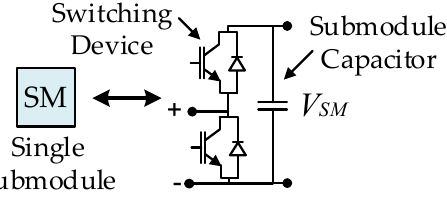
Figure 3. Schematic of a half-bridge submodule